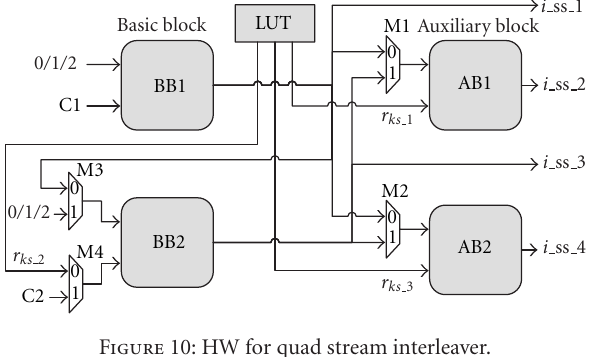
Figure 10: HW for quad stream interleaver.